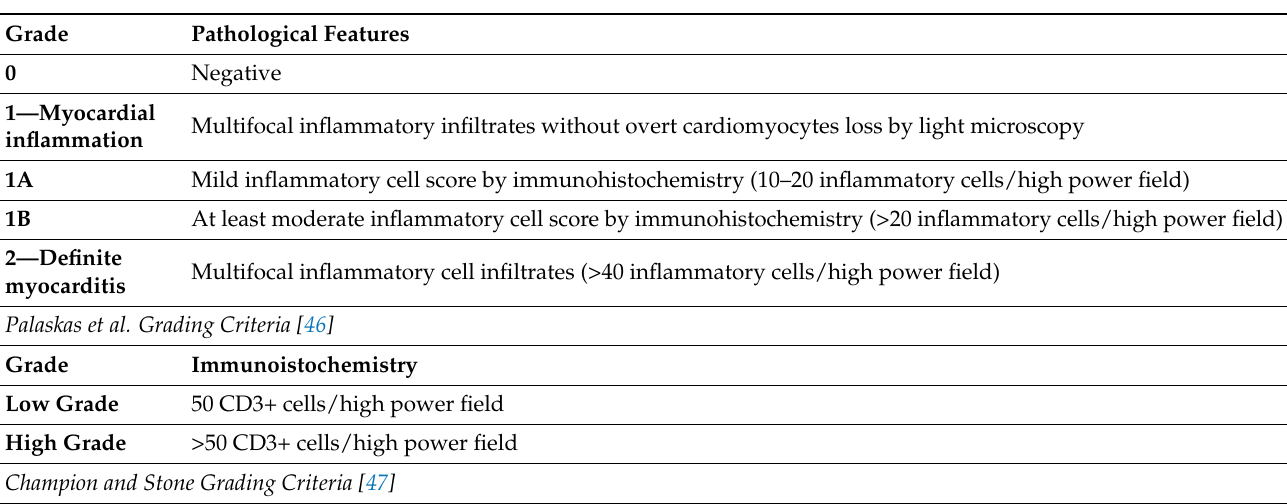
Figure 2. Cardiac magnetic resonance imaging in a patient with ICI-related myocarditis. Late gadolinium enhancement shows a non-ischemic pattern involving several segments of the left ventricle. Table 4. Current Pathology Grading criteria for ICI-induced myocardial